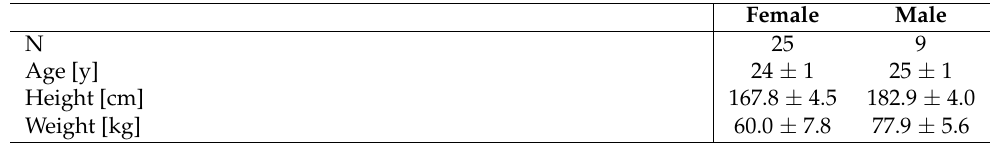
Table 1. Demographic characteristics of the study group; values presented as mean ± standard